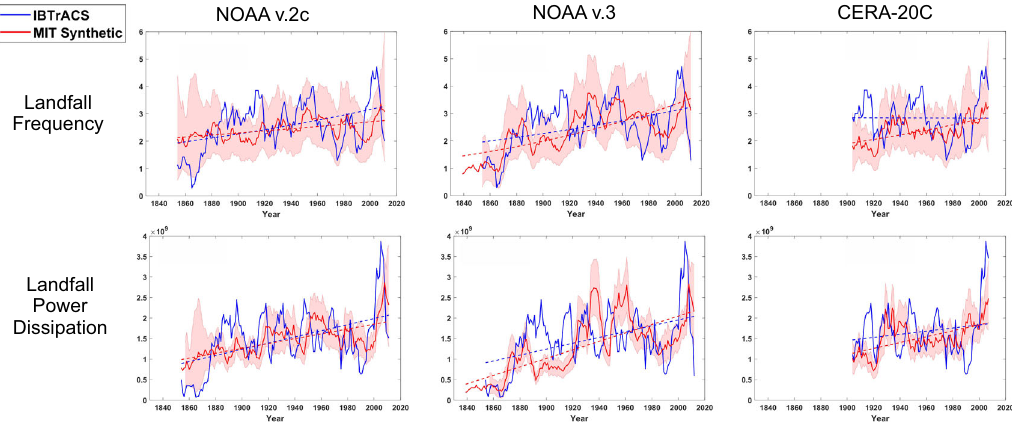
Fig. 2 As in Fig. 1 but showing the continental U.S. annual landfall frequency and U.S. landfall power dissipation index. The landfall frequency (top row) includes only storms whose lifetime maximum wind speeds exceed 40 kts (21ms − 1 ). The landfall power dissipation index (bottom row) is in units of m 3 s − 3 . The linear regression lines in the bottom row are from ordinary linear regression.